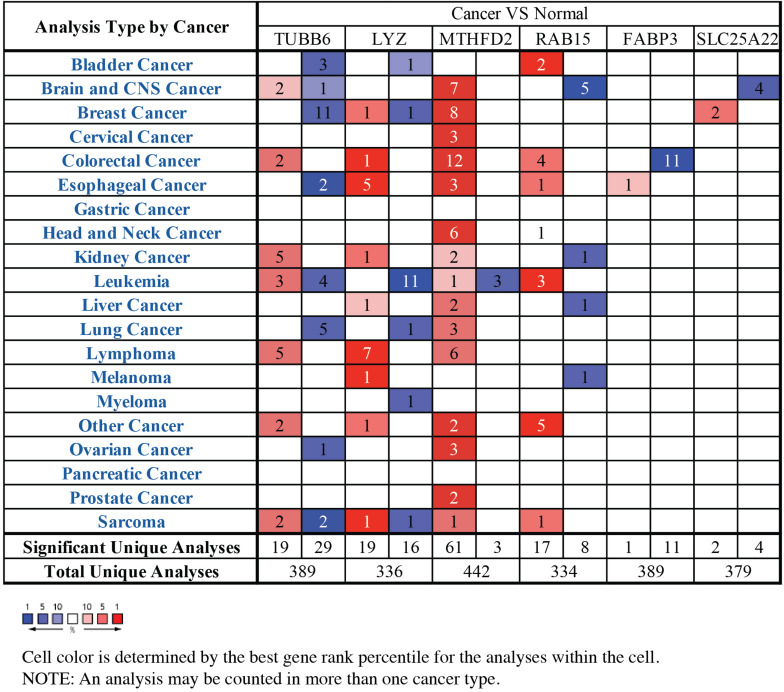
The mRNA expression patterns of prognostic-related genes in overall cancers. The mRNA expression difference between tumors and normal tissues were analyzed in Oncomine database. The number in the colored cell represents the number of analyses meeting these thresholds. The color depth was determined by the gene rank. The red cells indicated that the mRNA levels of target genes were higher in tumor tissues than in normal tissues, while blue cells indicated that the mRNA levels of target genes are lower in tumor tissues than in normal tissues.